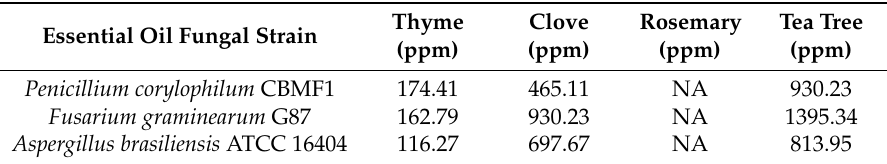
Table 4. Minimum inhibitory concentration (MIC) of essential oils tested against Fusarium graminearum